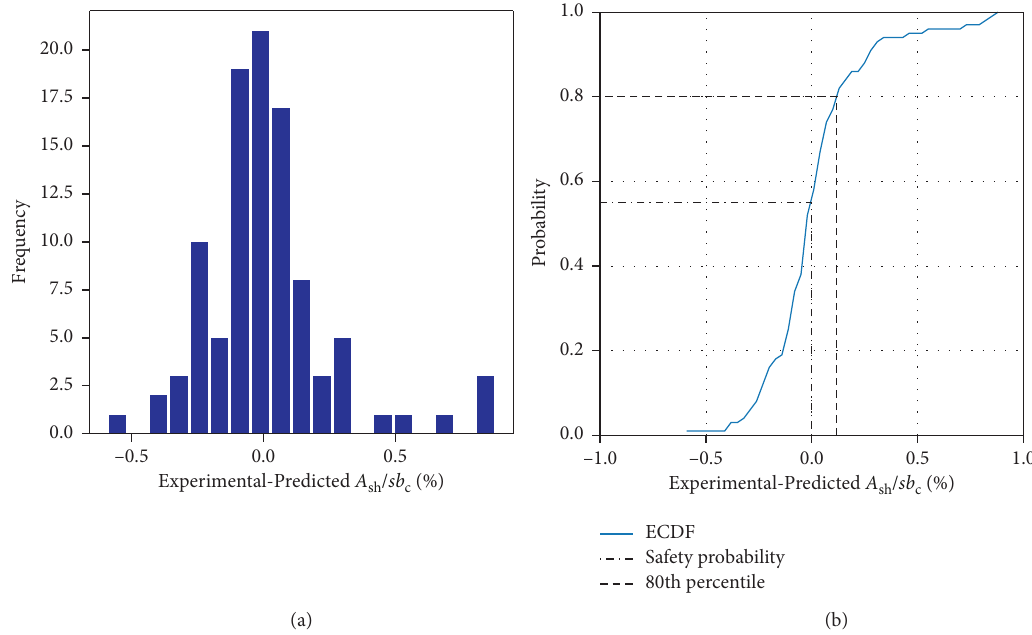
Figure 10: Distribution of the error between experimental and predicted transverse reinforcement ratio on testing set. (a) Histogram. (b) Empirical cumulative distribution function.